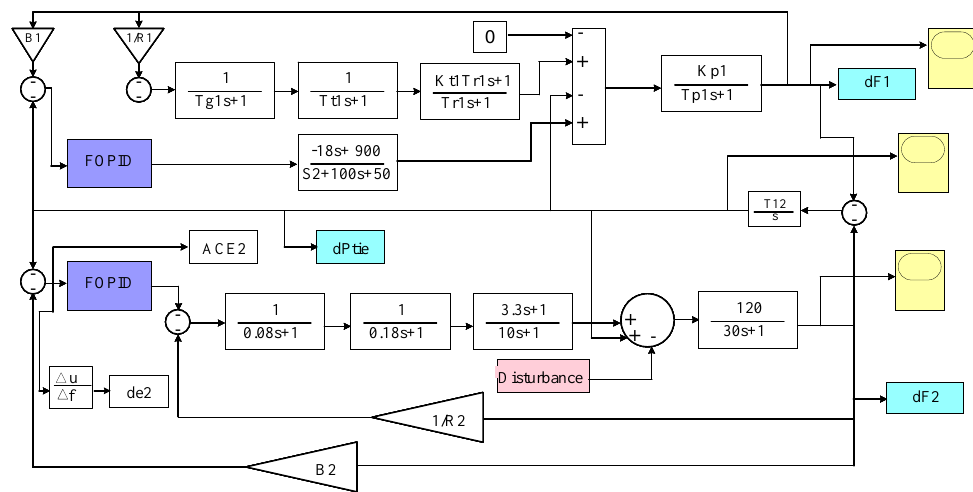
Figure 8. Two interconnected system scheme.